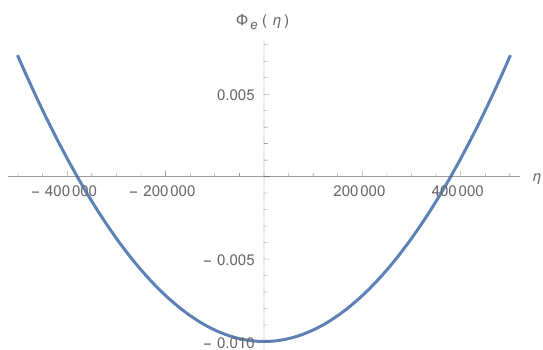
Figure 14. Time evolution of Φ e in the Jordan frame for the initial conditions Φ e ( 0 ) = − 10 − 2 , Ψ Φ (cid:48) ( 0 ) = 0, Ψ (cid:48) ( 0 ) = 0. The background evolution is the one obtained by assuming the e ( 0 ) = − 1, e e same initial conditions as mentioned in the caption of Figure 2.